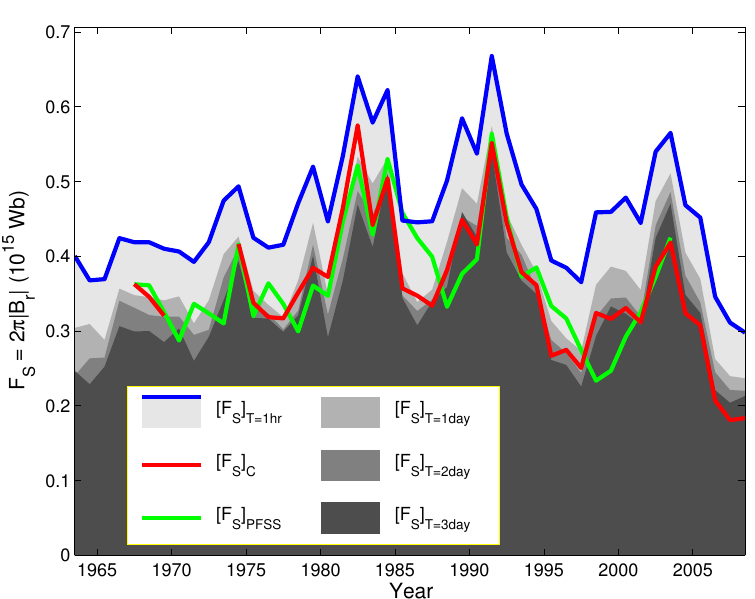
Figure 21: The variation of various open solar flux estimates during the space age. The gray-shaded areas show annual means of the signed open solar flux from the OMNI-2 data derived using Δ 𝐹 𝑆 = 0 and the absolute value of the radial field taken of means on timescale T : the light gray area bounded by the blue line is for T = 1 h, and successively darker gray areas are for T = 1, 2, and 3 days. The green line is the variation from solar magnetograms using the PFSS method. The red line shows the OMNI-2 values for T = 1 h, minus the correction term for kinematic effects, Δ 𝐹 𝑆 . Image reproduced by permission from Lockwood et al. (2009c), copyright by